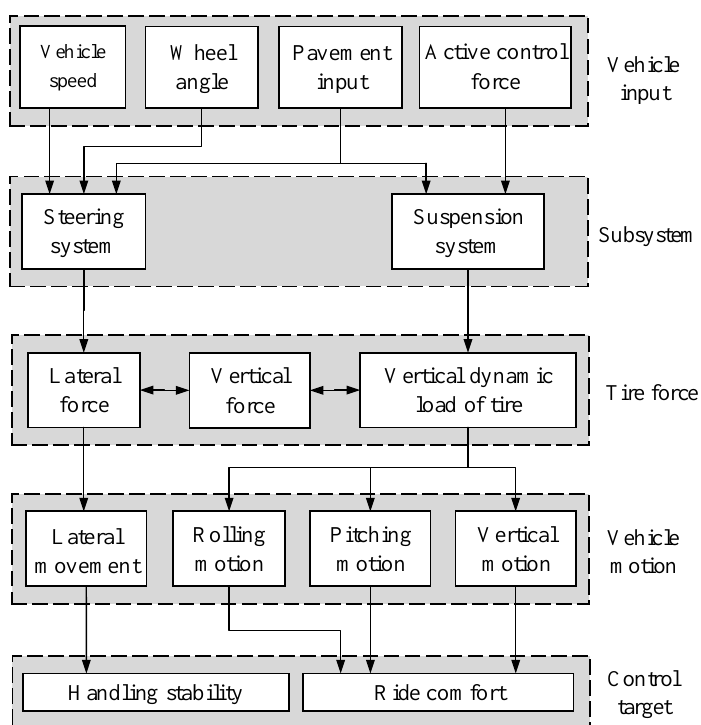
Figure 1. Coupling mechanism of active suspension system and steering system.